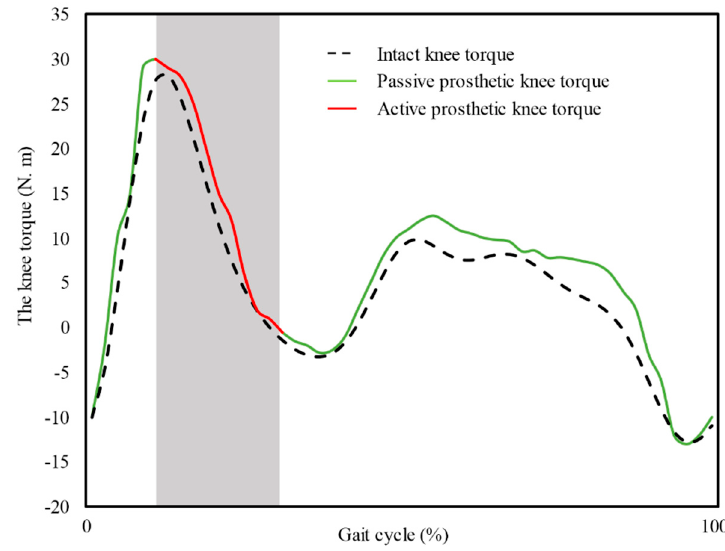
Figure 10. The prosthetic knee torque and intact knee torque. Table 3. The knee torque symmetry.